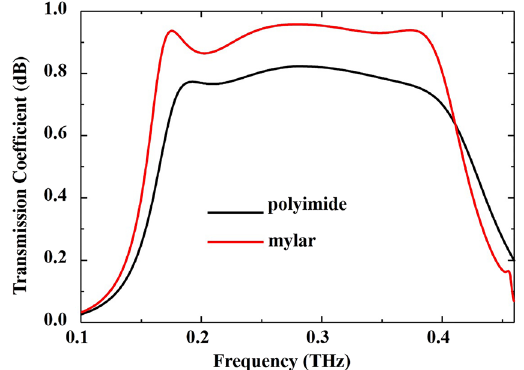
Figure 3. Transmission coefficient ( t xy ) for different dielectric spacers. The dielectric constants of polyimide and Mylar are 3.0 + 0.15 i and 3.1 + 0.02 i , respectively.